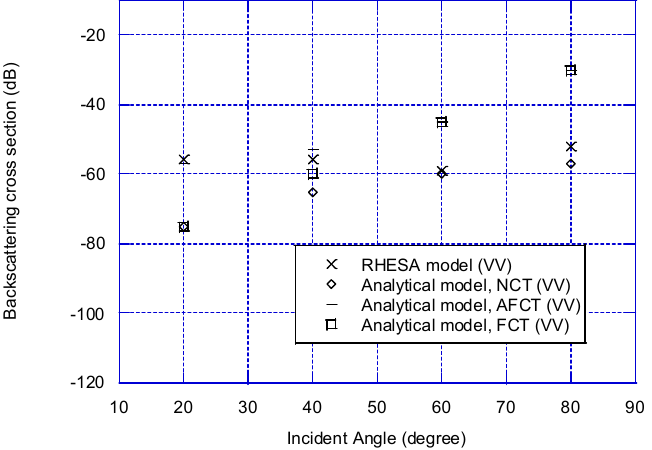
Figure 8. Comparison between theories for backscattering cross section of a cylindrical scatterer against incident angle, at 9.6 GHz frequency, with added results from analytical models with Fresnel phase corrections.